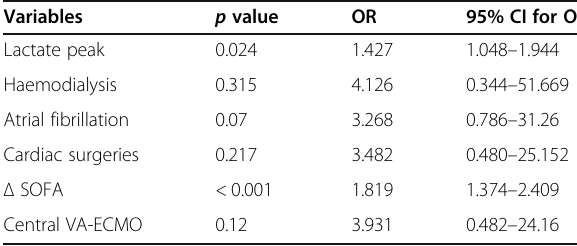
Table 5 Multivariable regression analysis for mortality of VA- ECMO-treated patients